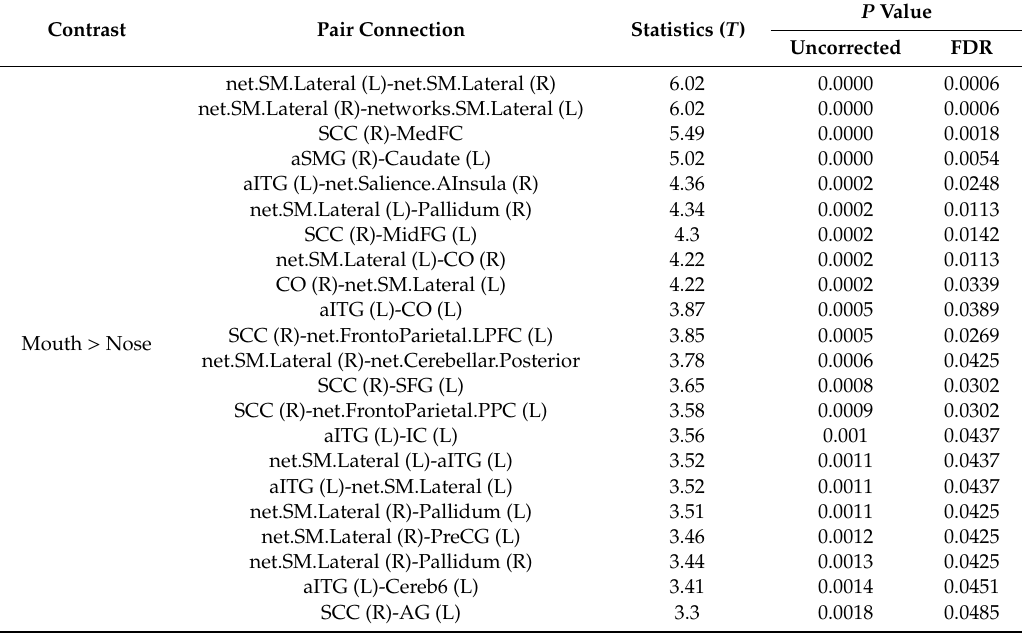
Table 1. Mouth > Nose contrast ROI connections with threshold ROI to ROI connections by intensity at